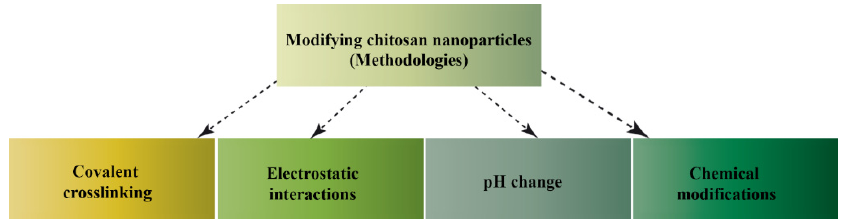
Figure 3. Methods to modify chitosan